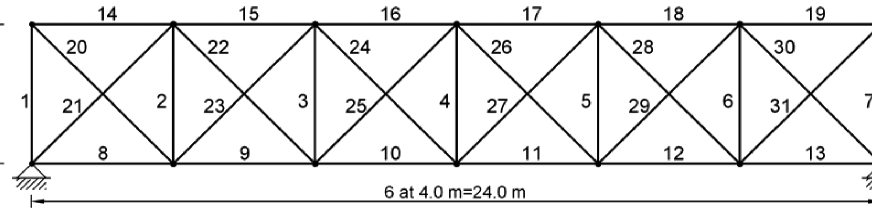
Fig. 8. Plane steel truss with fi nite-element